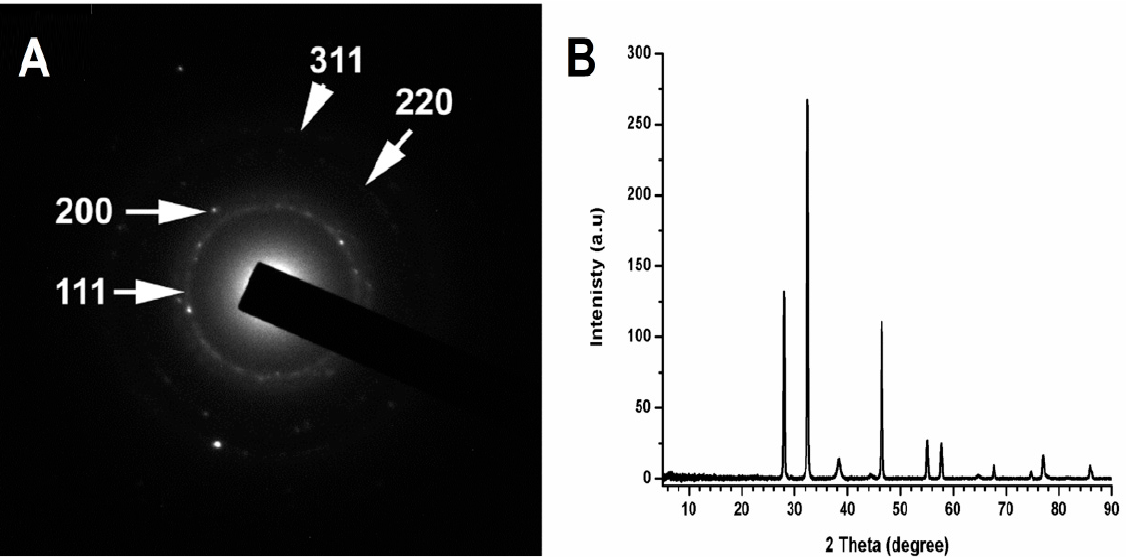
Figure 3. ( A ) Selected area electron diffraction (SAED) pattern analysis of AgNPs; ( B ) XRD pattern of AgNPs.